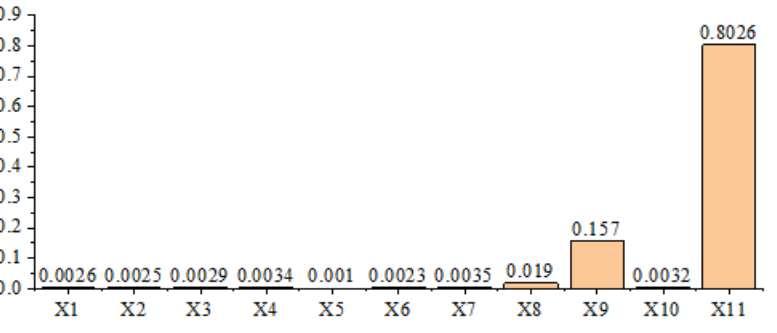
Figure 3. The importance ratio of each input vector.